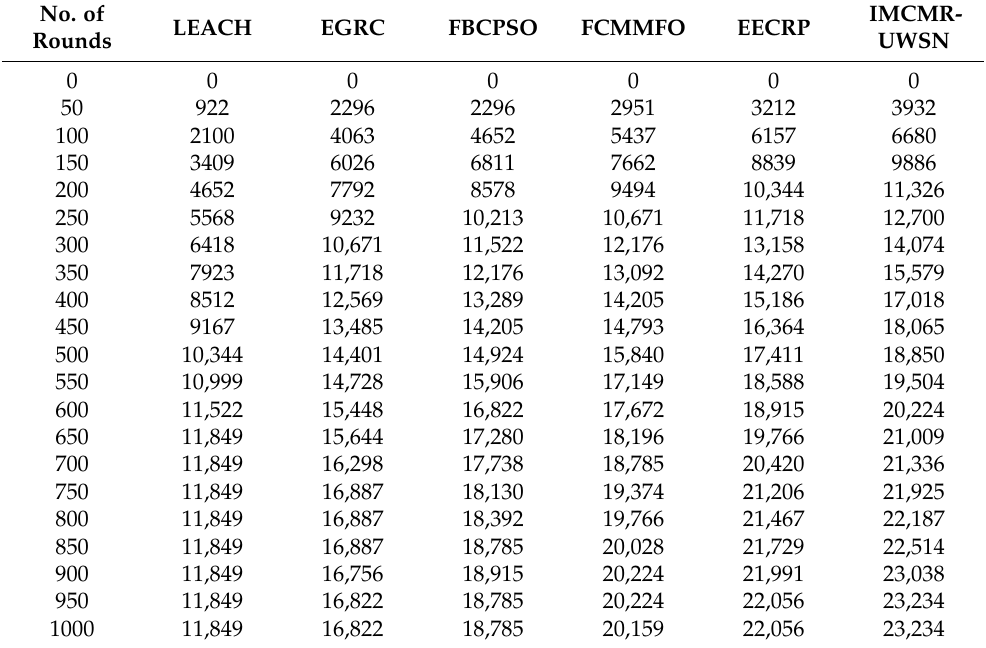
Table 3. Number of packets received analysis of the IMCMR-UWSN technique with different rounds. No.